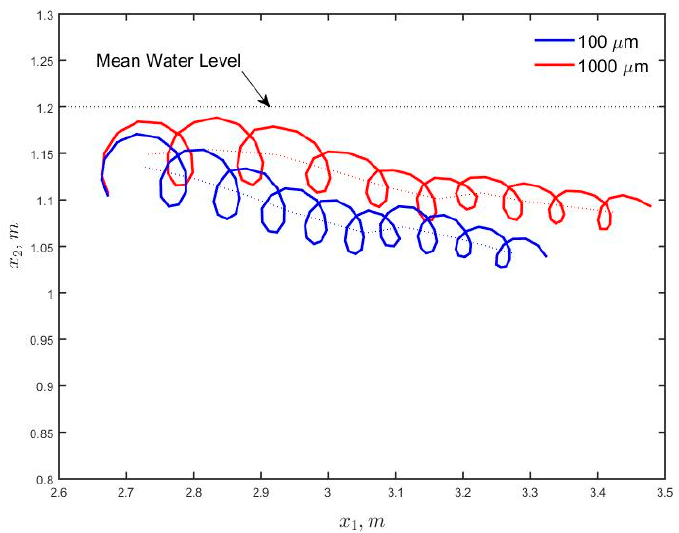
Figure 8. Ensemble averaged plume trajectory (over 500 particles of each size) of particles of diameter 100 and 1000 μ m. The particles were released at x 1 ∈ [ 2.5, 3 ] m, x 2 = 1.10 m. The dotted line through the plume trajectory was obtained by window averaging over each trajectory loop corresponding to the wave period.